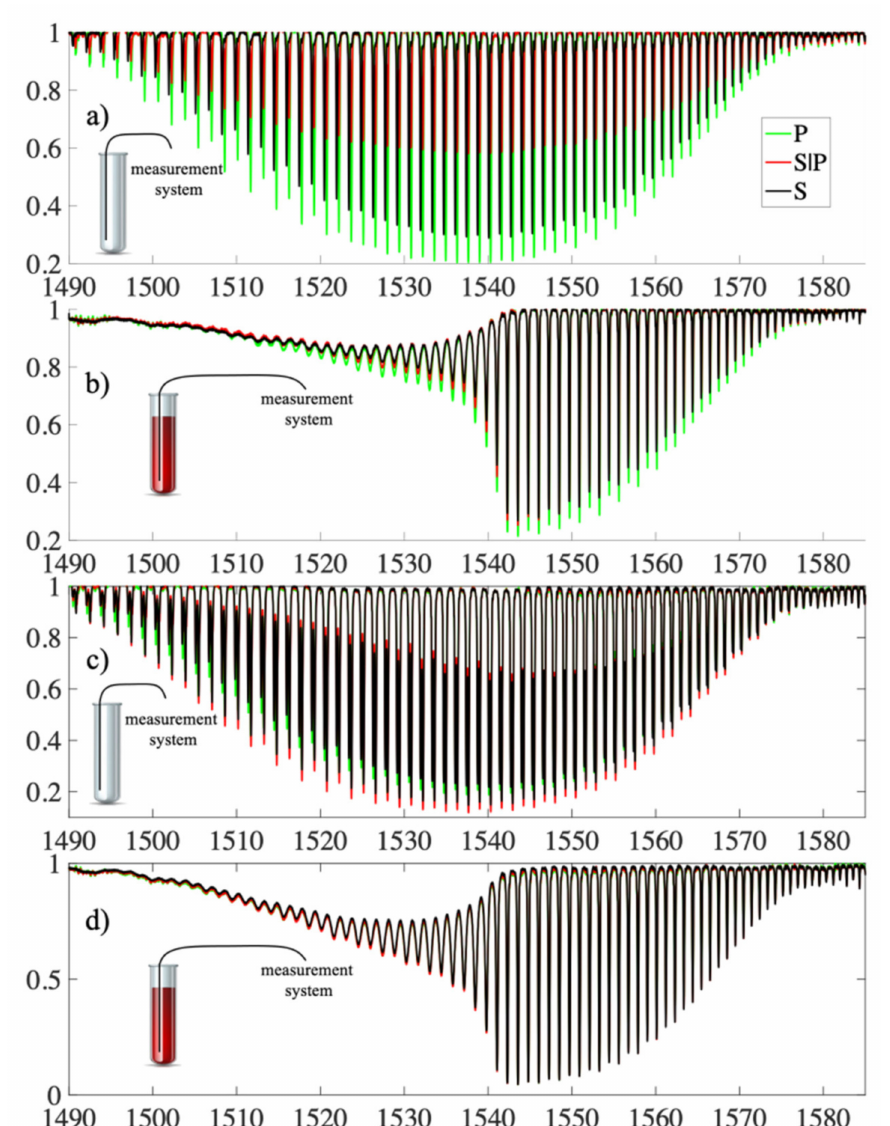
Figure 22. Measured spectral characteristics showing the response of the sensors to changes in polariza- tion P, S|P and S for the cases: ( a ) TFBG air, ( b ) TFBG solution, ( c ) P-TFBG air, ( d ) P-TFBG